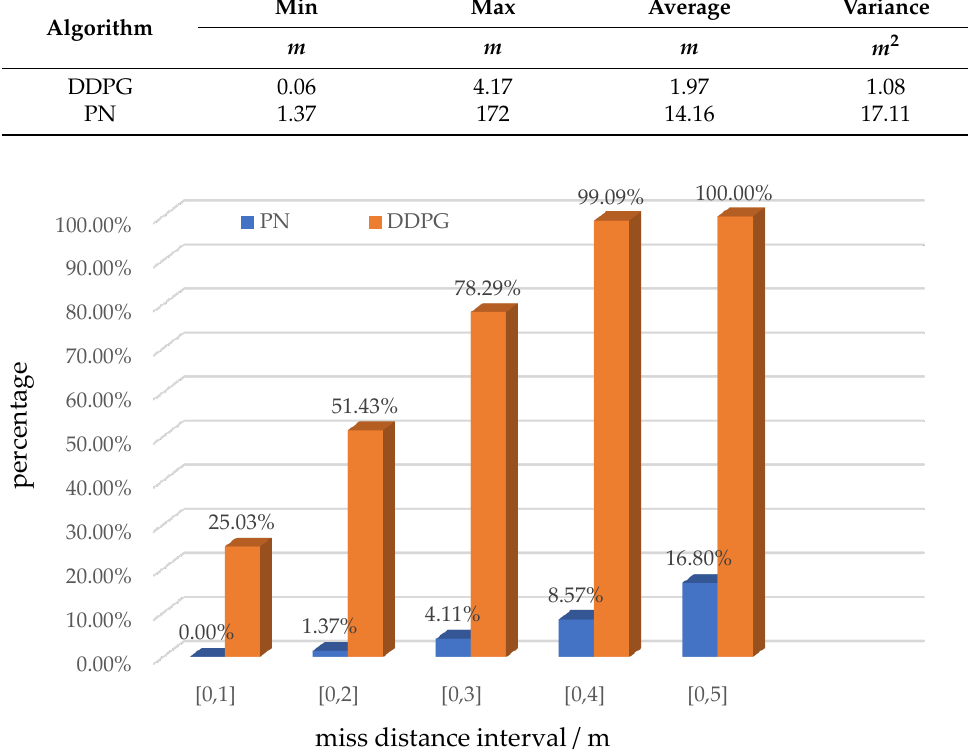
Figure 8. Distribution of miss distance.